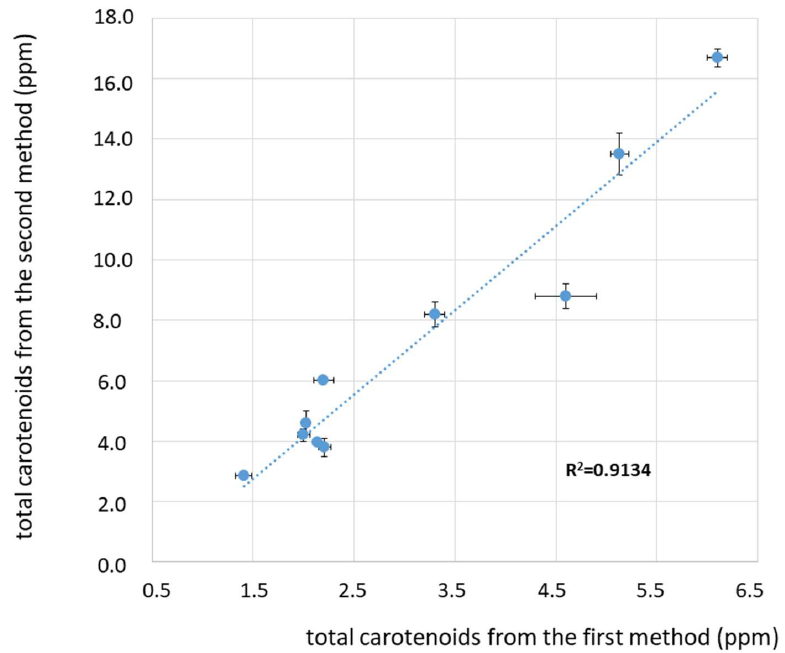
Figure 4. Plot of the amount of total carotenoids (ppm) for the investigated olive oil samples as obtained from the two spectroscopic methods: Values obtained with the method proposed by M í nguez-Mosquera et al. [11] on the abscissa and by Domenici et al. [17] on the ordinate. A linear curve is shown, which correlates the two values, as described in the text. Each data point is displayed with an error bar corresponding to the confidence interval (CI). The R 2 value corresponding to the linear regression fit is also